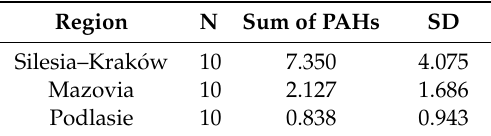
Table 2. Number of samples (N), sum of PAHs (ng kg − 1 d. wt.) and SD calculated for Pleurozium schreberi collected in three regions in